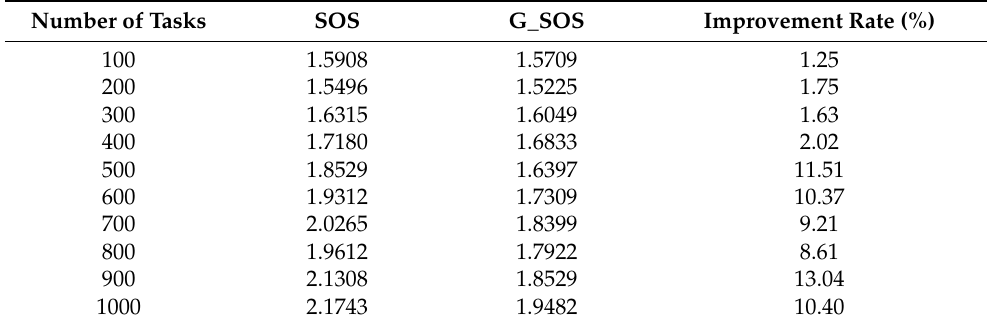
Table 10. Comparison of Degree of Imbalance between SOS and G_SOS for a uniformly distributed dataset.